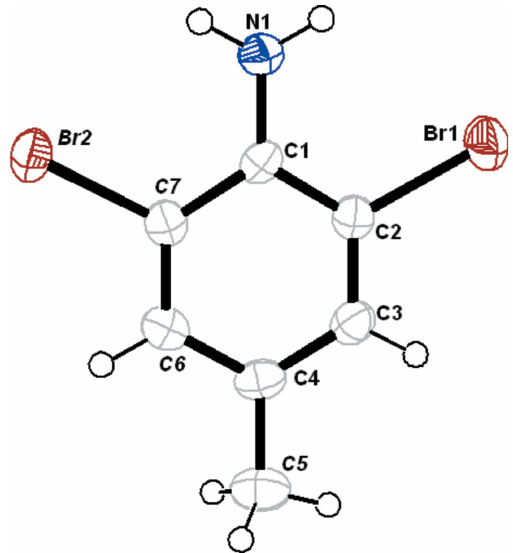
Figure 1 The molecular structure of the title compound showing displacement ellipsoids at the 50% probability